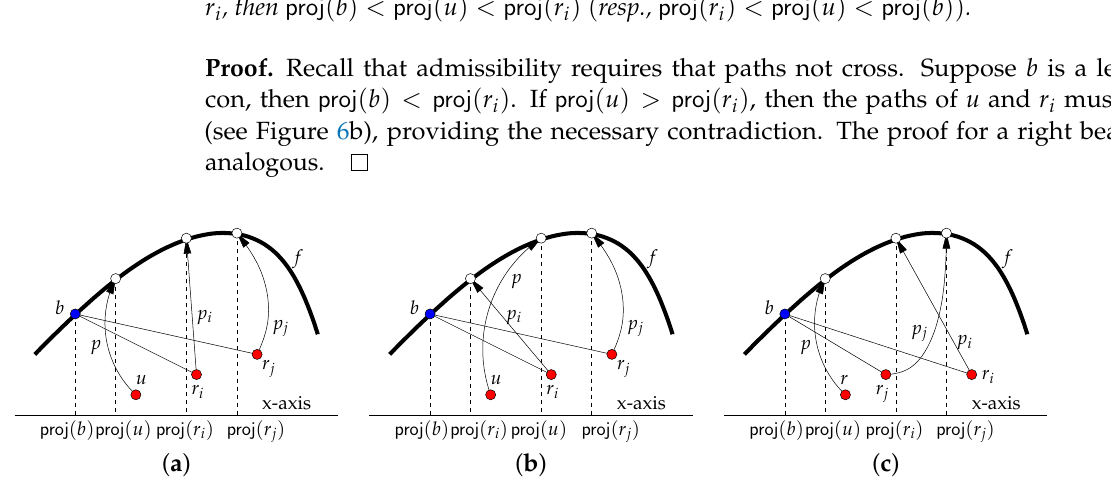
Figure 6. An illustration of the proofs of Lemmas 3 and 4: ( a ) illustrates no path crossing for the robots even when the transient robot u blocks the beacon b from r i and/or r j when they move, and ( b , c ) illustrate a path crossing